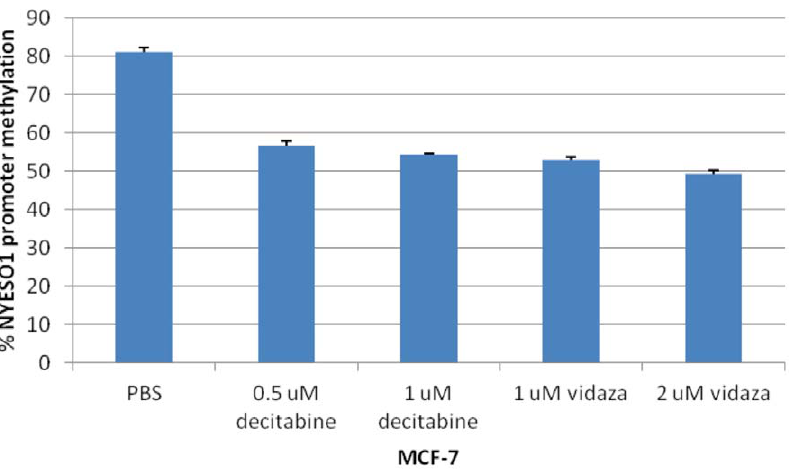
Figure 7. NY-ESO-1 promoter methylation was reduced by both decitabine and 5-azacytidine in MCF-7 cells. Graph showing that NY- ESO-1 promoter methylation was reduced by both decitabine and 5-azacytidine in MCF-7 cells.